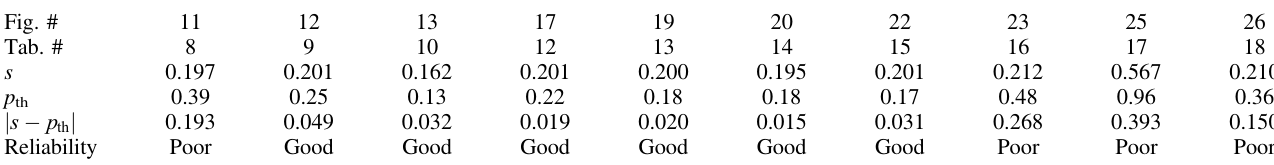
Table 1. Summary of climatological base rate ( s ) and threshold probability maximizing PSS ( p th ) appeared in Barnes et al. (2016). Fig. # 26 Tab.